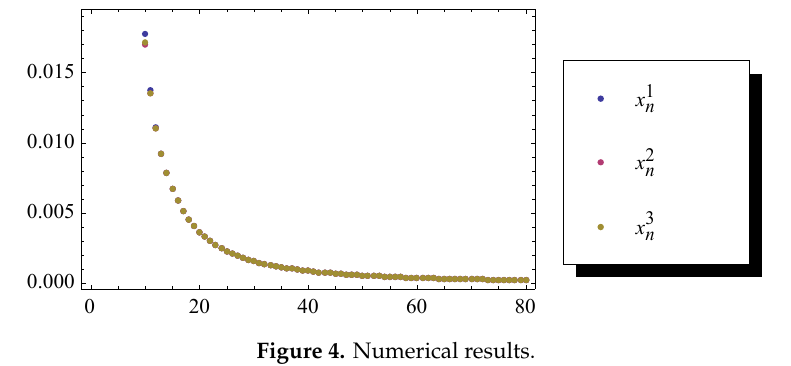
Figure 4. Numerical results.